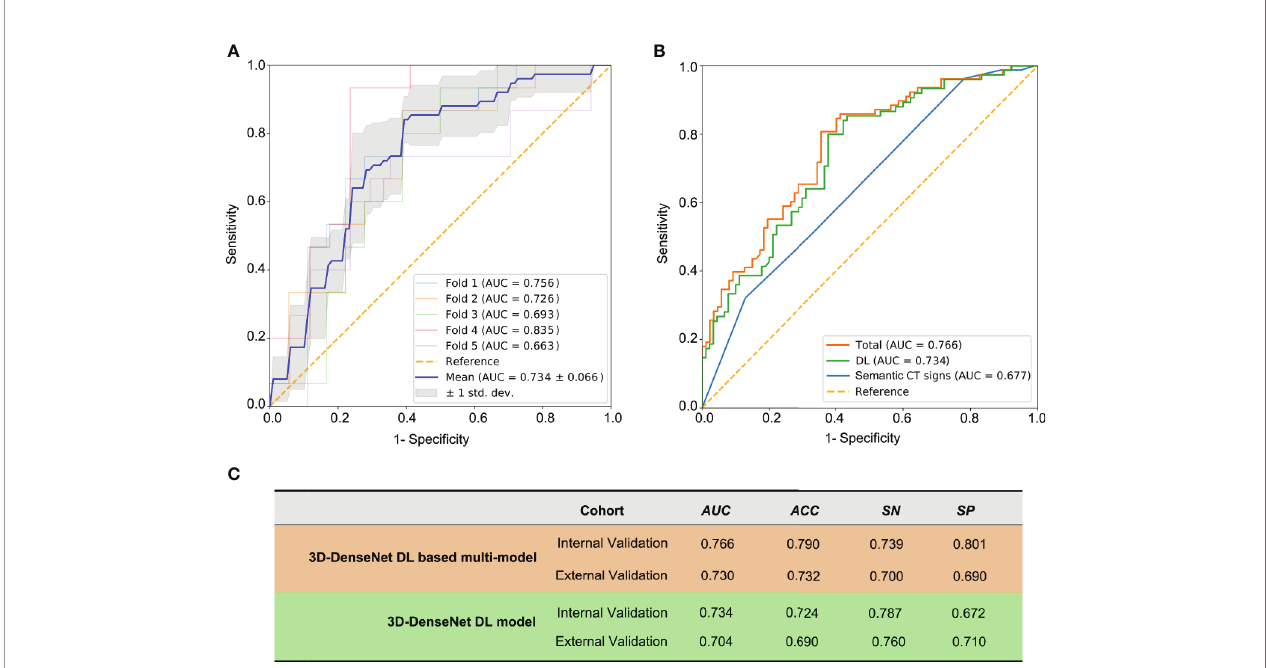
FIGURE 3 | The prediction metrics of 3D-DenseNet-DL and DL based multi-model. The metrics Area Under ROC Curve (AUC), ACC (accuracy), SN (sensitivity), and SP (speci fi city) were used to compare the performance of these models. (A) The prediction metrics of the deep learning results from training and fi ve-fold cross- validation, a mean AUC of 0.734 ± 0.066 was presented. (B) The comparison of three models of semantic CT signs model, 3D-DenseNet-DL model, and the comprehensive model (3D-DenseNet-DL based multi-model), with a mean AUC of 0.677, 0.734, and 0.766, respectively. (C) Values of 3D-DenseNet-DL model and 3D-DenseNet-DL based multi-model in external validation, with AUC 0.704, ACC 0.690, SN 0.760, and SP 0.710 for DL model, and AUC 0.730, ACC 0.732, SN 0.700, and SP 0.690 for our fi nal 3D-DenseNet-DL based